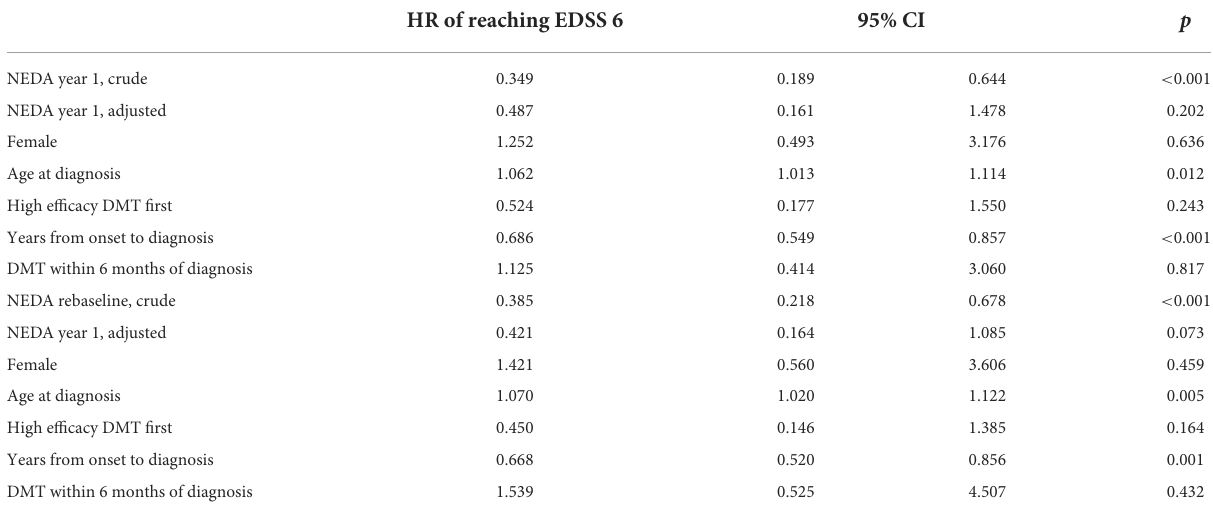
TABLE 4 Hazard ratio of reaching EDSS 6 in those who did and did not achieve NEDA at year one and at rebaseline, before and after adjustment using cox regression